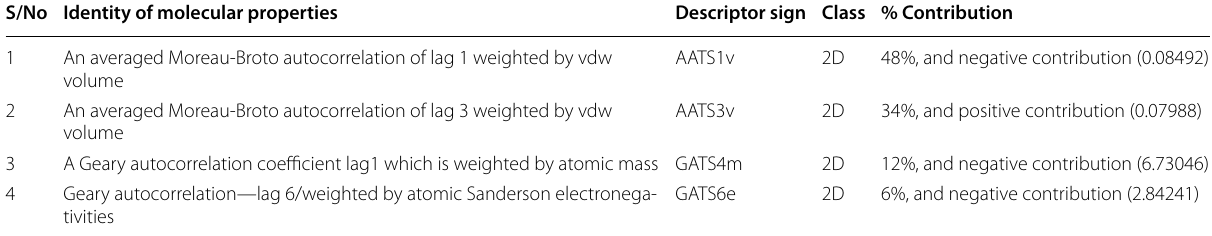
Table 3 Molecular properties utilized in the MLR model